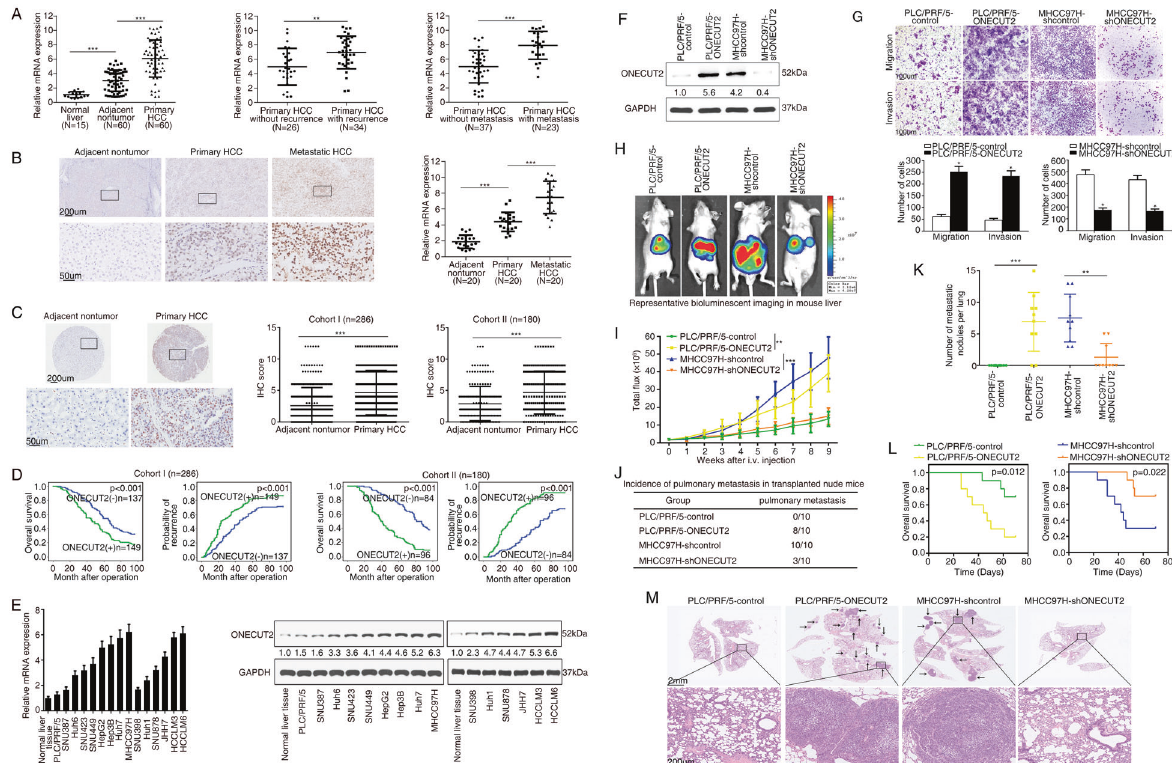
Fig. 1 ONECUT2 is overexpressed in HCC tissues and accelerates HCC metastasis. A Left: ONECUT2 mRNA levels were detected in 15 normal liver tissues and 60 pairs of HCC and adjacent nontumor tissues by RT-PCR. Middle: ONECUT2 mRNA levels in HCC samples from patients with recurrence ( n = 34) or without recurrence ( n = 26). Right: ONECUT2 mRNA levels in HCC samples from patients with metastasis ( n = 23) or without metastasis ( n = 37). B Representative IHC staining (left) and RT-PCR (right) showing ONECUT2 levels in 20 pairs of fresh metastatic and matched primary HCC tissues and adjacent nontumor tissues. C Representative IHC staining (left) and IHC scores (right) showing ONECUT2 levels in two HCC cohorts. D Prognosis of HCC patients was compared between negative and positive ONECUT2 expression group by Kaplan – Meier method in two HCC cohorts. E RT-PCR (left) and western blotting (right) showing ONECUT2 levels in normal liver tissues and HCC cells. F Protein levels of ONECUT2 were measured by western blotting when PLC/PRF/5 cells were transfected with